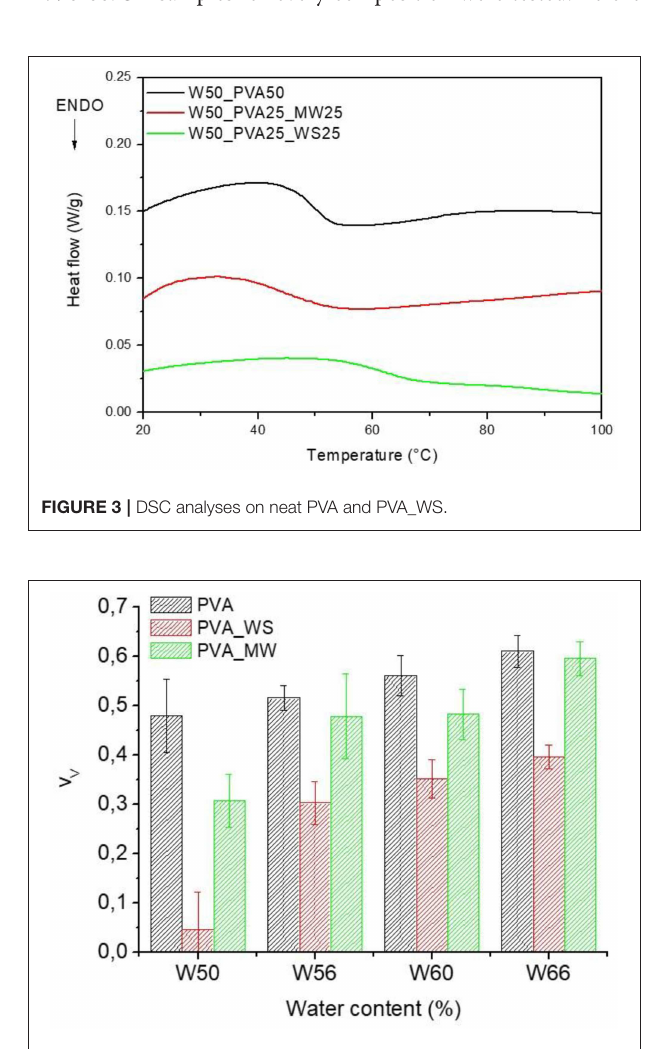
FIGURE 4 | Void fraction for PVA samples (v v ) with different amounts of